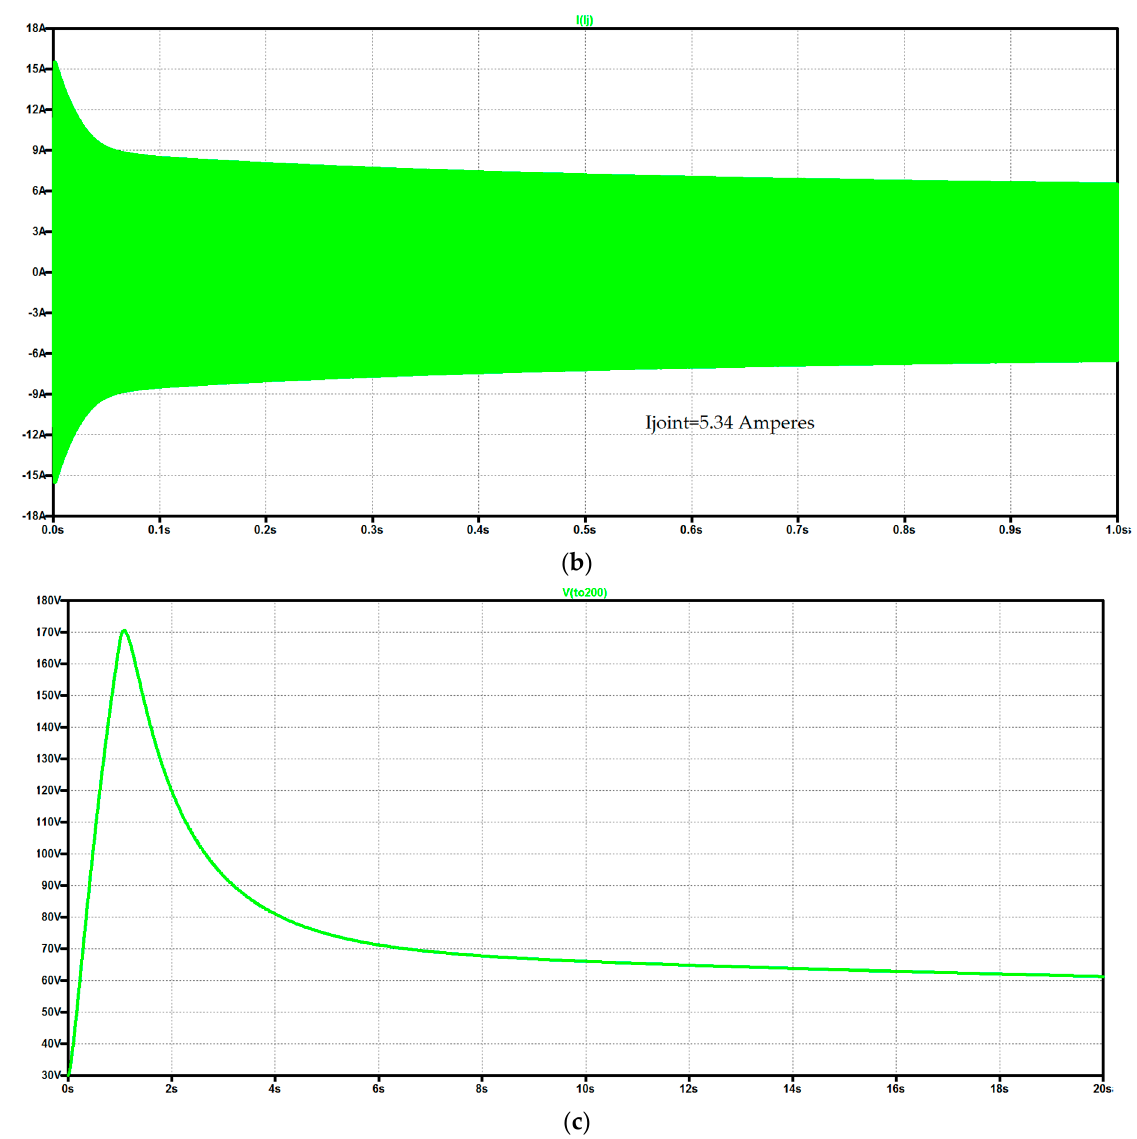
Figure 7. Electrothermal non ‐ contact welding model: ( a ) LTspice simulation model for IOFEF welding; ( b ) Simulation result of one second current through IOFEF joint; ( c ) Simulation result of 20 s temperature at Lo200.